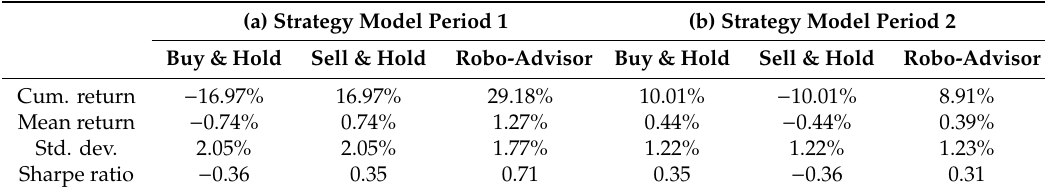
Table 4. Mean return, standard deviation and Sharpe ratios of the di ff erent strategies for each period for the out-of-sample